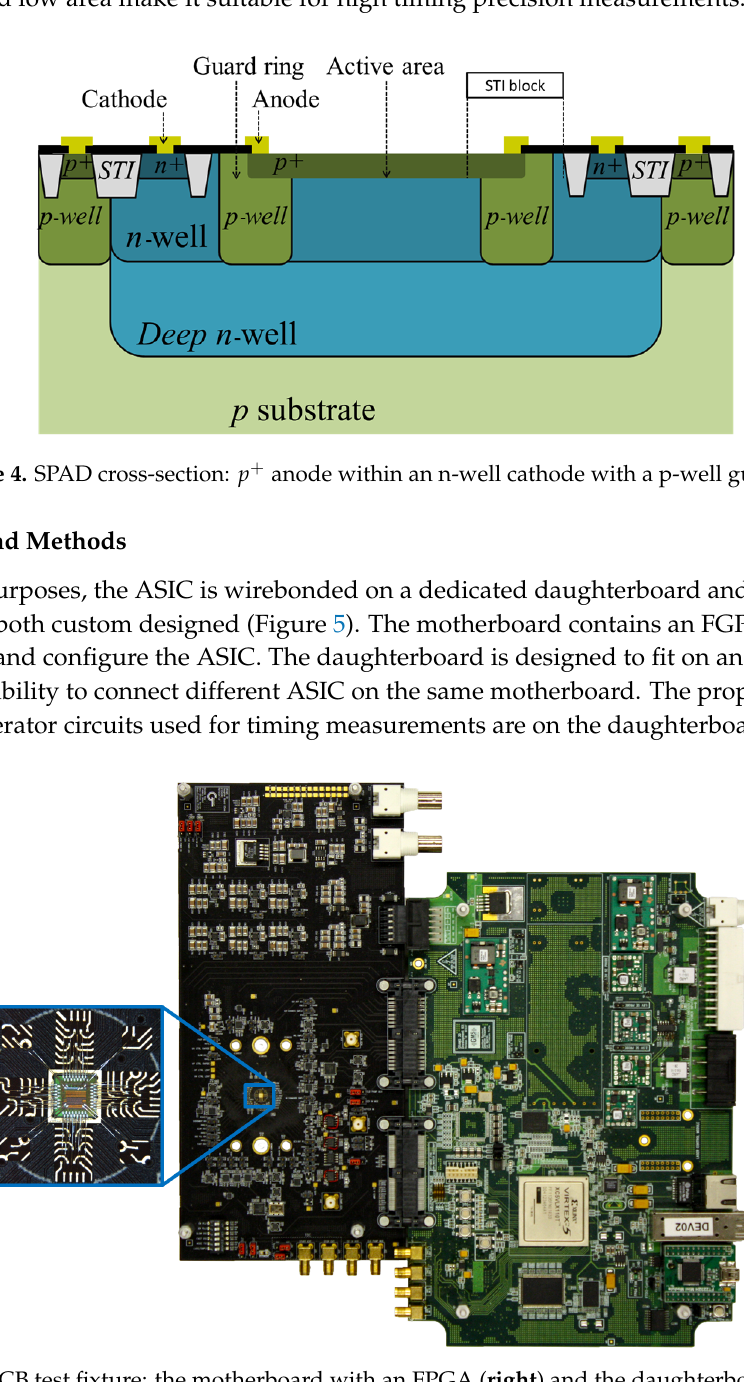
Figure 5. PCB test fixture: the motherboard with an FPGA ( right ) and the daughterboard where the ASIC is wirebonded ( left